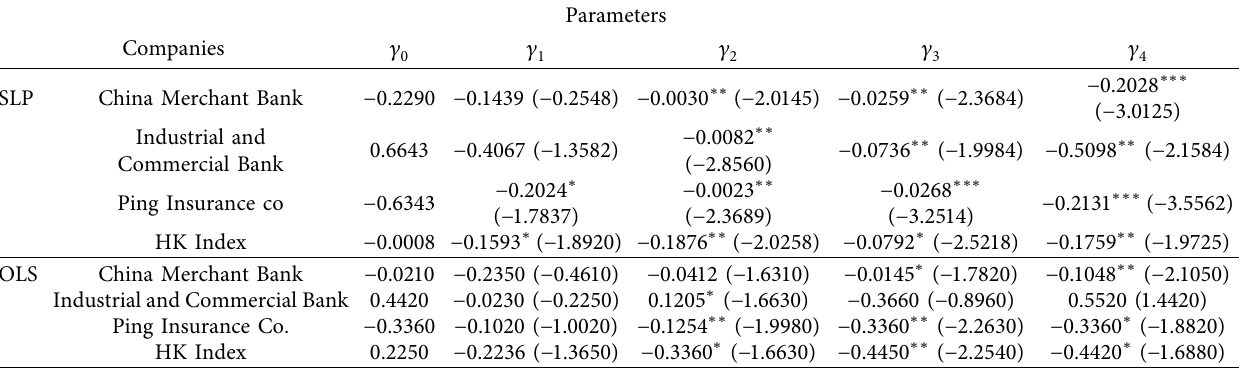
∗∗∗ , ∗∗ , and ∗ indicate significance at the 1%, 5%, and 10% levels,